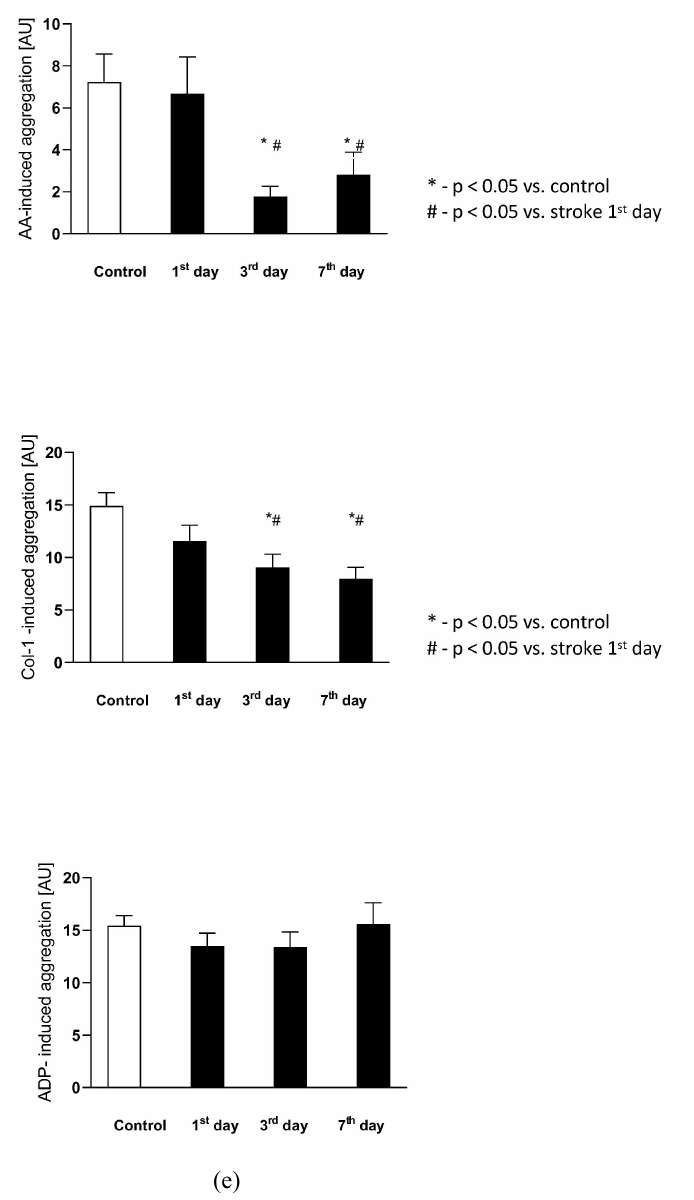
Figure 4. ( a ) The plasma nitric oxide metabolic pathway metabolites in the control group and the study group. Abbreviations: Plasma L-Arginine (L-Arg-plasma), the plasma asymmetric dimethy- larginine (ADMA-plasma), the plasma symmetric dimethylarginine (SDMA-plasma), L-Arginine to ADMA ratio in plasma (L-Arg/ADMA-plasma). ( b , c ) The intraplatelet nitric oxide metabolites in the control group and the study group. Abbreviations: L-Arginine in platelets (L-Arginine-platelet), asymmetric dimethylarginine in platelets (ADMA-platelet), symmetric dimethylarginine in platelets (SDMA-platelet), dimethylamine in platelets (DMA-platelet), L-Arginine to asymmetric dimethy- larginine ratio in platelets (L-Arginine-platelet/ADMA-platelet), asymmetric dimethylarginine to dimethylamine ratio in platelets (ADMA-platelet/DMA-platelet). ( d ) The balance of the NO biotrans- formation metabolites between the platelet and plasma compartment. Abbreviations: L-Arginine in platelet to L-Arginine in plasma ratio (L-Arg-platelet/L-Arg-plasma), asymmetric dimethylarginine (ADMA), symmetric dimethylarginine (SDMA). ( e ) Platelet aggregation in the control group and the study group. Abbreviations: arachidonic acid-induced aggregation (AA-induced aggregation), collagen-1-induced aggregation (COL 1-induced aggregation), adenosine diphosphate- induced aggregation (ADP-induced aggregation), *— p < 0.05 vs. control, #— p < 0.05 vs. stroke in the first day.